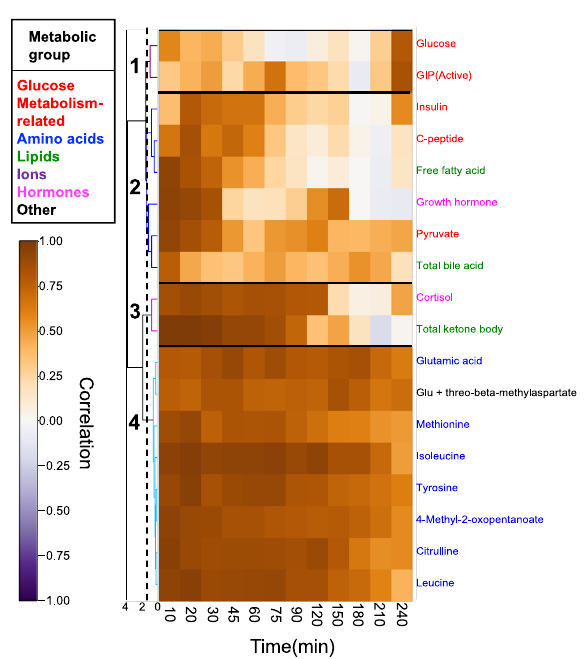
Fig. 5 Correlation of values for each molecule. A heat map shows the correlation coef fi cients between the fasting and each time point (in minutes (min)) among individuals. The 18 glucose-responsive molecules showed a signi fi cant change after glucose ingestion was selected. Molecules are ordered by hierarchical clustering using Euclidean distance and Ward ’ s method. The colours and numbers on the tree diagram indicate the cluster of each molecule. The dashed line indicates the threshold for dividing the cluster. The colours assigned to the names of molecules correspond to the metabolic group (inset). Abbreviations for the molecules are follows: GIP (active), gastric inhibitory polypeptide (active); Glu glutamic